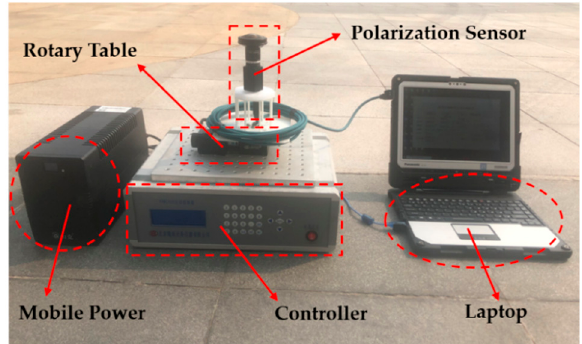
Figure 12. Setup for outdoor test.